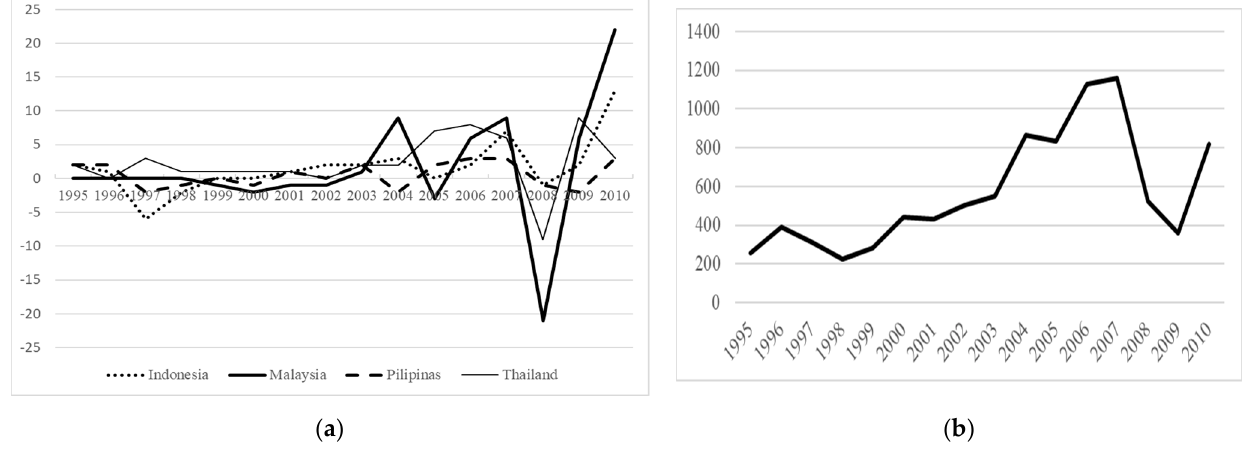
Figure 6. ( a ) Non-Resident Portfolio Investment (Unit: the US $1 Billion), sourced by EIU country data; ( b ) Non-Resident Portfolio Investment in the US (Unit: the US $1 Billion), sourced by EIU country data.